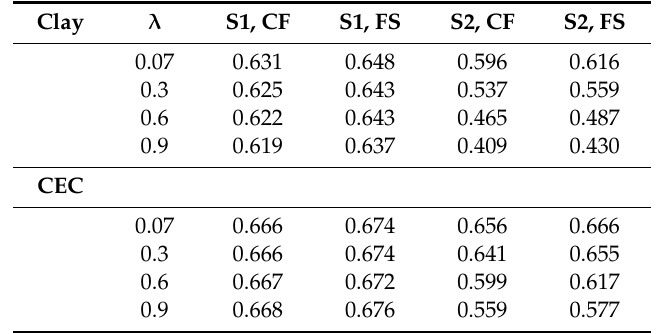
Table 5. Coe ffi cient of determination (R 2 ) achieved between the measured clay and CEC with the estimated true electrical conductivity ( σ ) generated by inverting EM38 apparent electrical conductivity (EC a —mS / m) using the EM4Soil quasi-3D model, cumulative function (CF) or full solution (FS), algorithms S1 or S2, and various damping factors ( λ ).